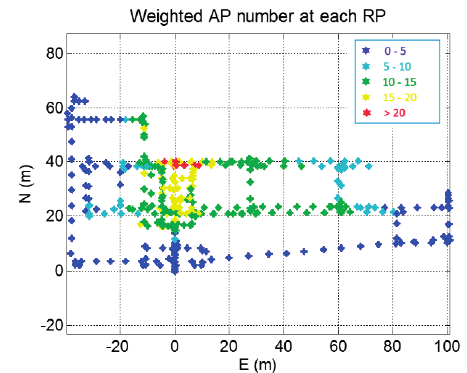
Figure 5. WiFi signal distribution at EEEL.